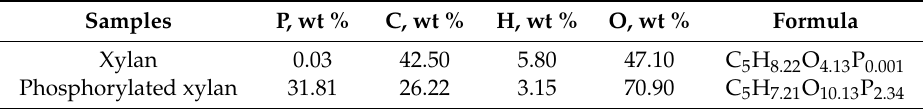
Table 4. The elemental analysis of xylan and phosphorylated